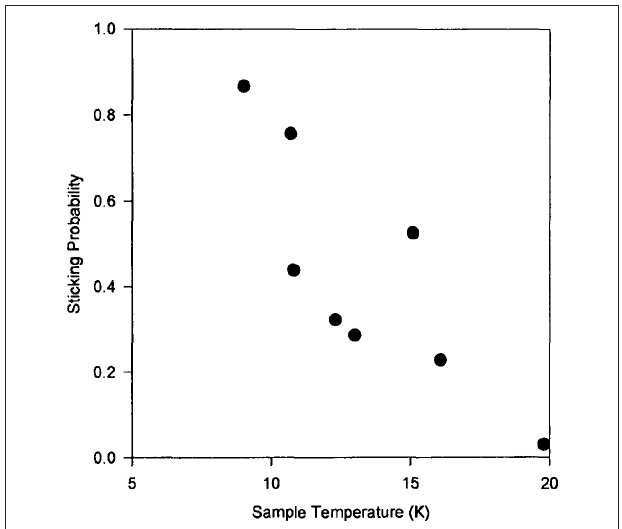
FIGURE 2 | Sticking probability of H atoms on amorphous carbon sample as a function of the sample temperature. From Pirronello et al. (2000), reproduced with permission of the Cambridge University Press through PLSclear.